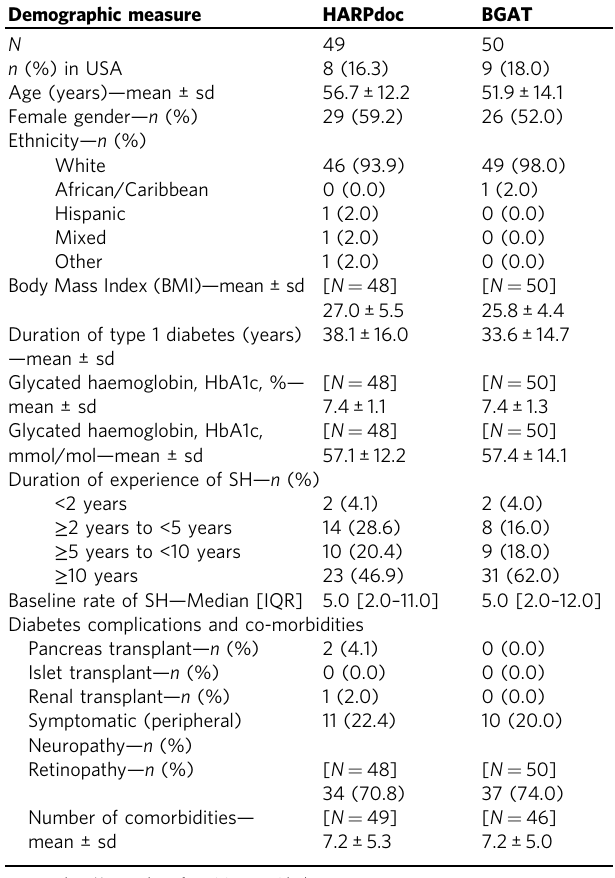
Table 1 Baseline characteristics of participants in the HARPdoc RCT by intervention arm. Demographic